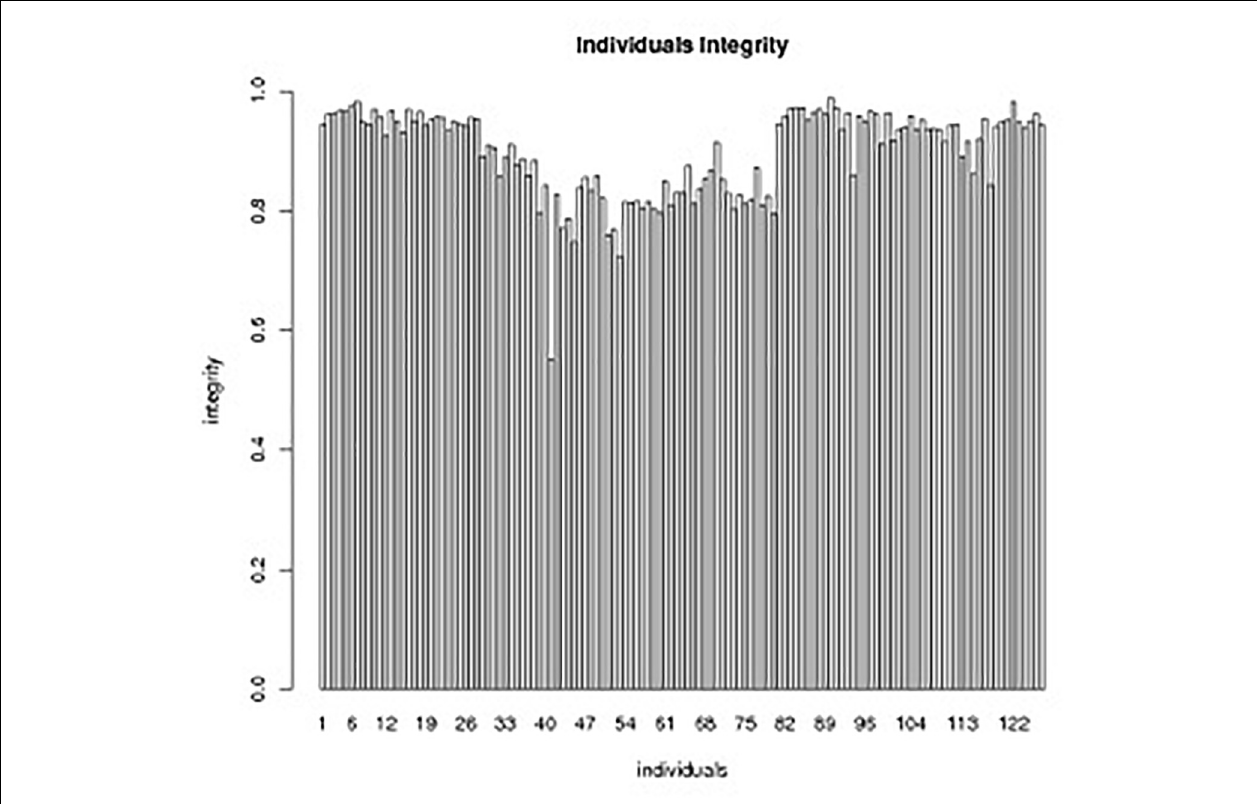
FIGURE 5 | Individual integrity of SLAF markers in the genetic map.The x -axis indicates the individual DH lines in the segregation group, and the y -axis shows the number of markers.